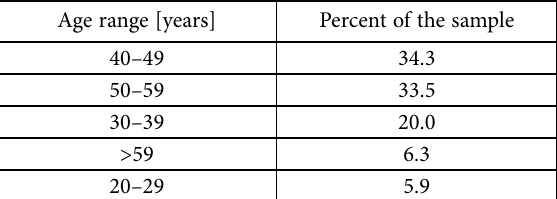
Table 3. The riders’ age distribution